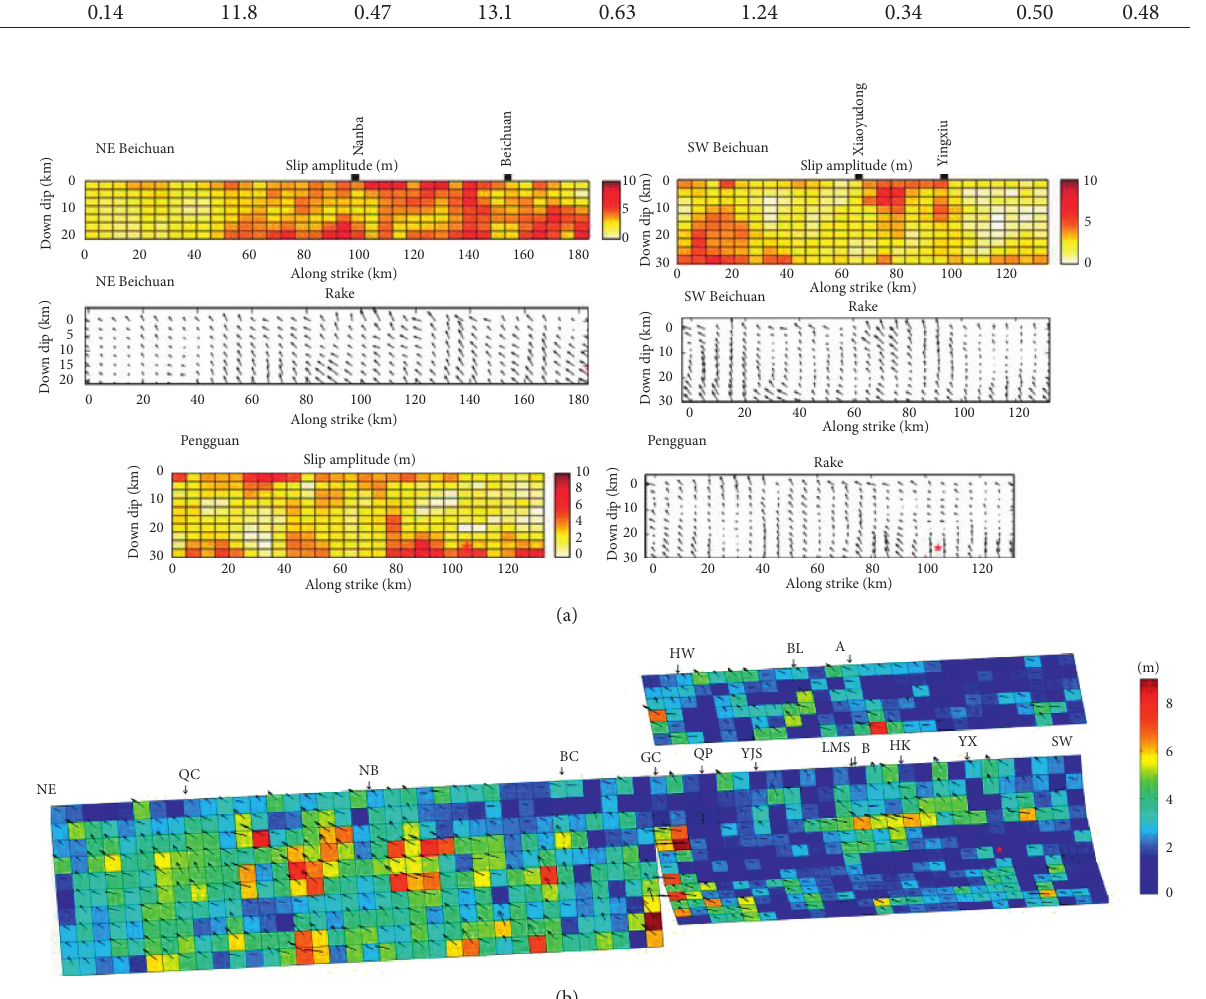
Figure 10: The inversion result of strong-motion data [1] (a) and this article (b).